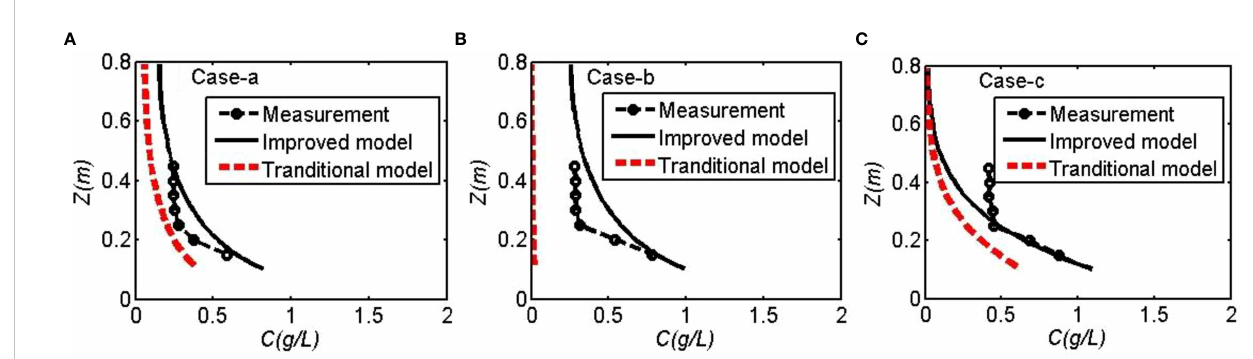
FIGURE 5 Measured and simulated sediment concentrations in Test 2: (A) Case-a, (B) Case-b, (C) Case-c.